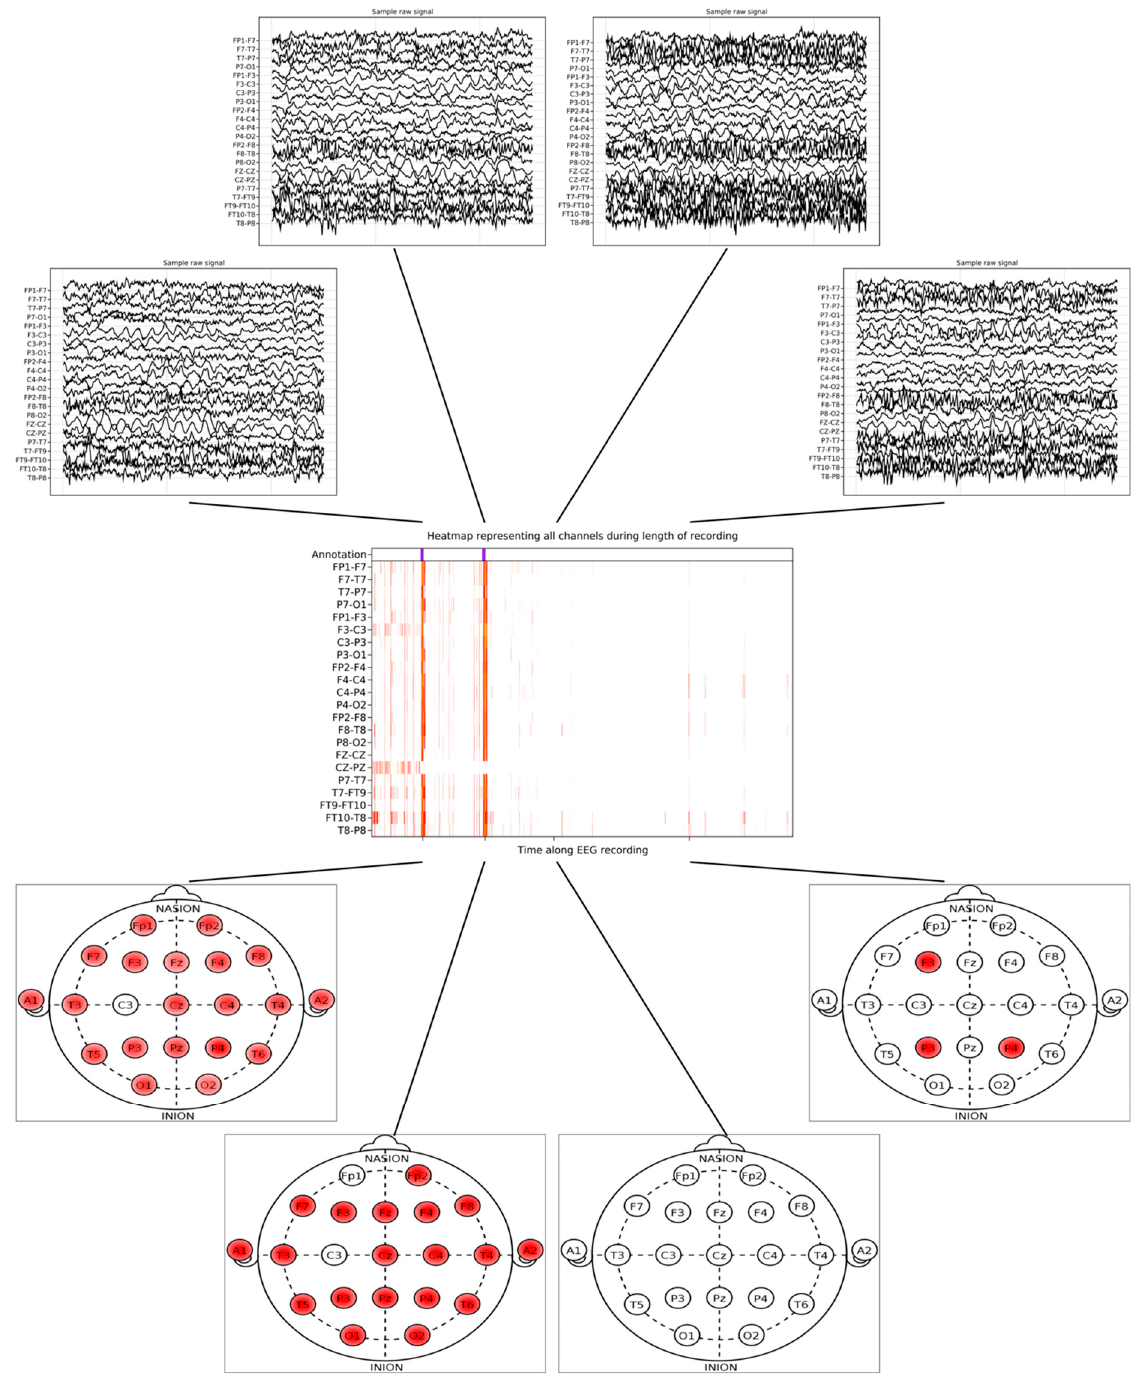
Figure 3. MindReader sample recording interpretation on subject chb04 (male 22 years old), record 28. Top plots illustrate MindReader ‘s output on EEG montage at four different time points during the recording. Middle heatmap shows MindReader ‘s hypothesized states along the recording per channel. Original Physionet manual annotation is indicated on top. Bottom plots display original EEG signals from same time points as interpretations.